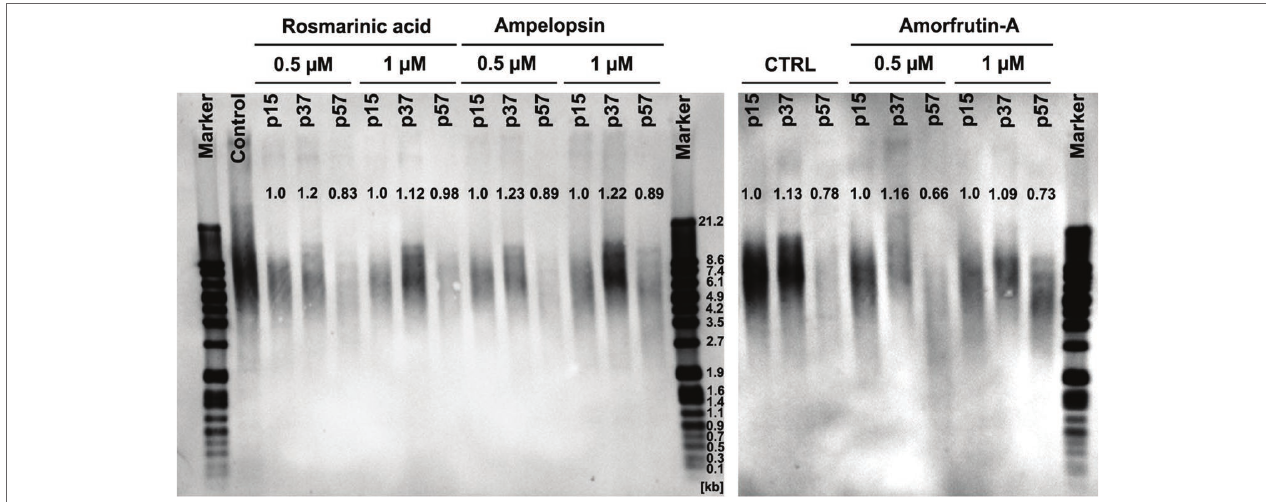
FIGURE 5 | Telomere restriction fragment (TRF) length, by Southern blot analysis, in serially passaged PCS cells at different passage levels, with and without continuous exposure to selected concentrations of test compounds. Mean TRF was calculated using GelAnalyzer software and normalized to appropriate controls at